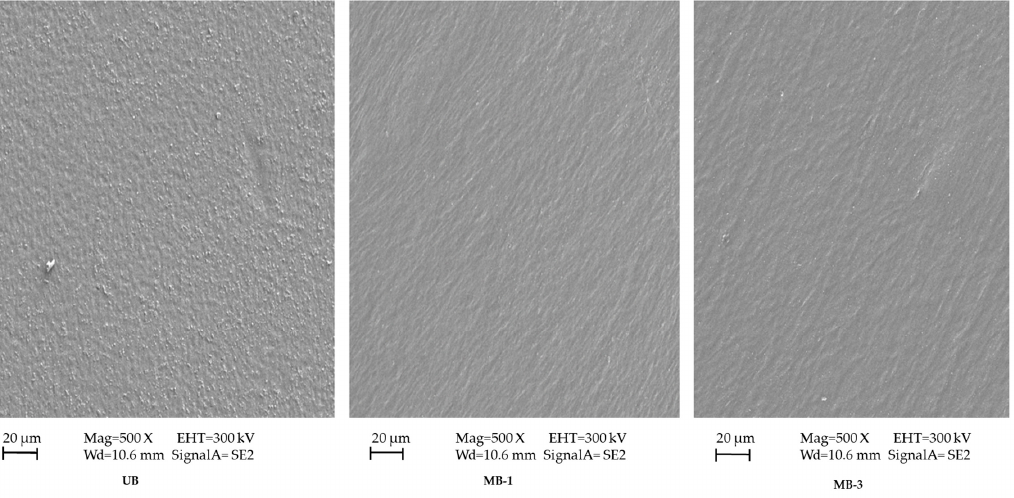
Figure 4. SEM of different blend film formulations.